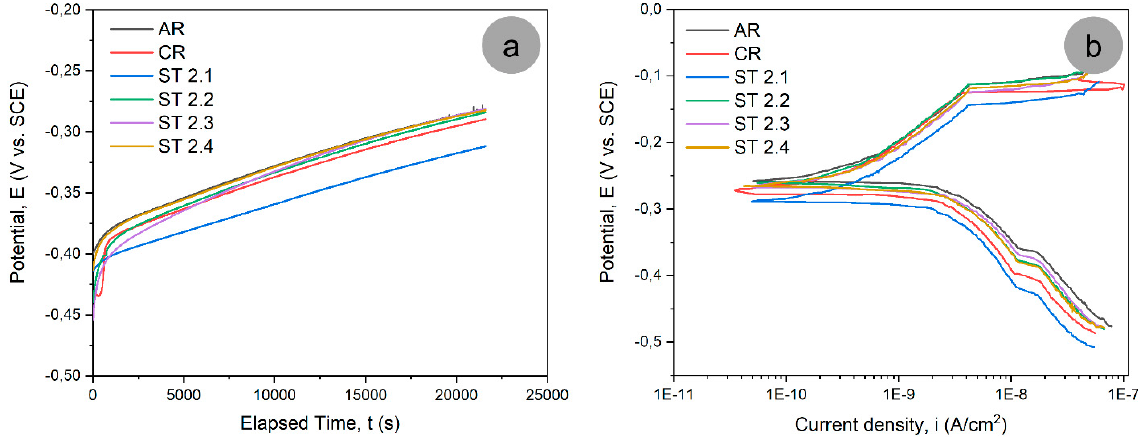
Figure 11. Evolution of the open circuit potential (E OC ) ( a ) and Tafel curves ( b ) for TMP processed TNTZ alloy .